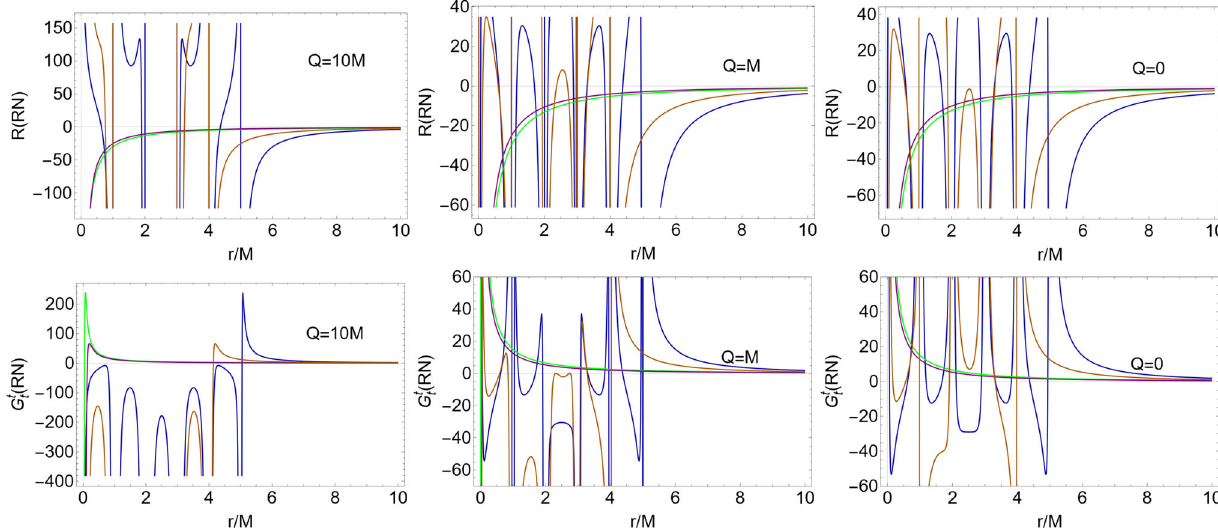
Fig. 20 DeformationoftheReissner–Nordströmreferencemetricwith θ = π/ 2. Curvature scalar R (upper line panels) and Einstein ten- sor component G t t (bottom line panels) for different charge parame-